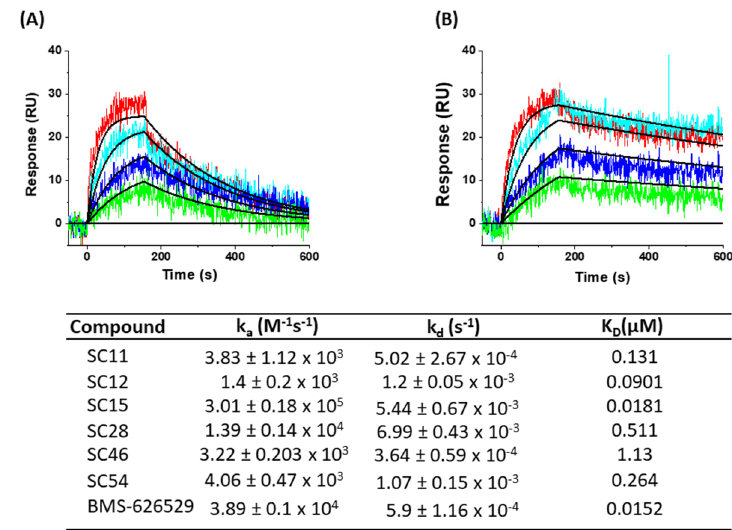
Figure 2. Sensorgrams depicting the interaction of ( A ) SC46 and ( B ) SC54 with recombinant trimeric HIV-1 B41 SOSIP Env. Colored lines represent the raw data of the different concentrations of compound used, and the black lines represent the fit that was derived using a 1:1 binding model. A table showing the interaction parameters for all compounds used in this study is also provided.